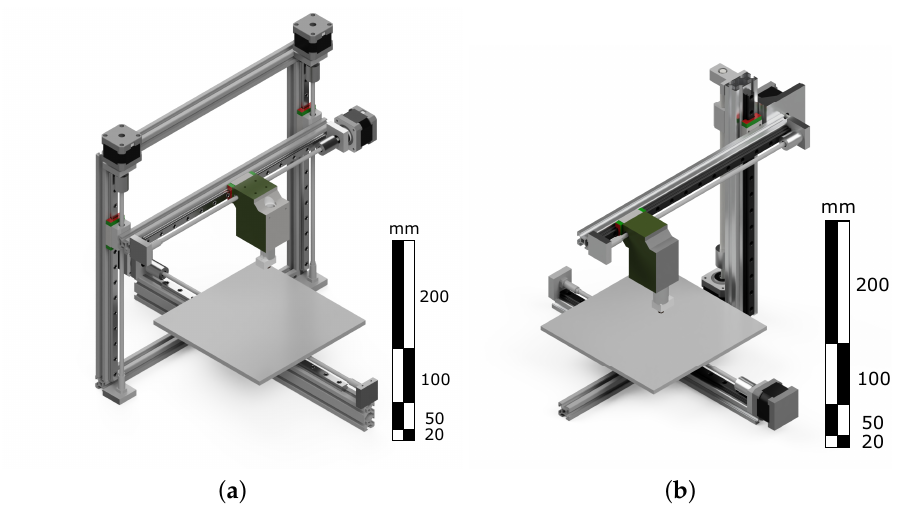
Figure A3. 3D model of 3D printers with fixed axes X B , Y H , Z B and actuated axes X H , Y B , Z H ( a ) with closed axes X H , Y B and open Z H ( b ) with open X H , Z H axes and open Y B .